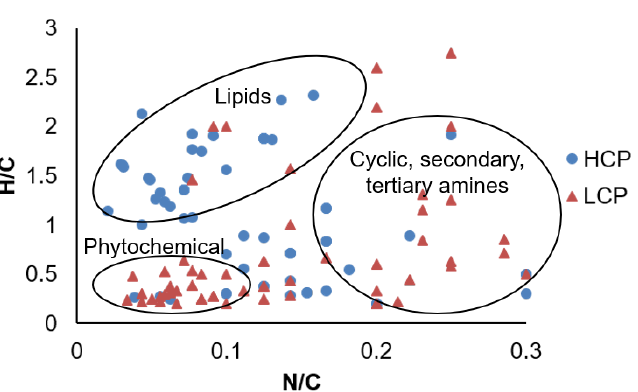
Figure 5. van Krevelen plot using N/C ratio instead of O/C ratio to explore nitrogen dynamics in Arctic LMW DOM pool.